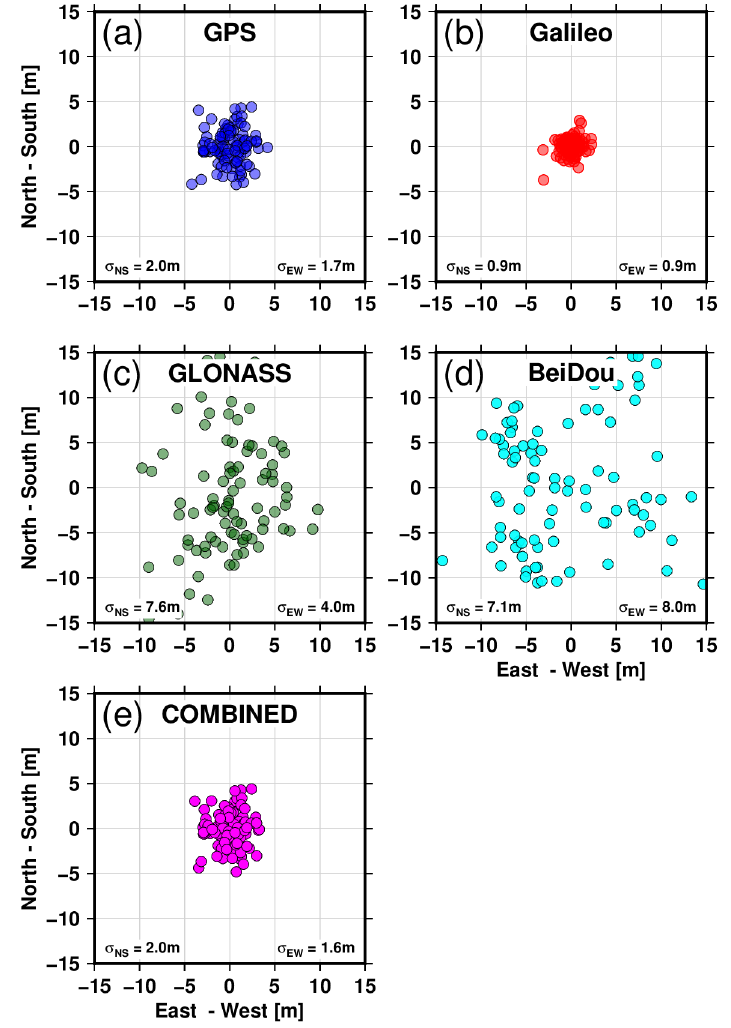
Figure 12. Single-point positioning for site KBG2, which has no Eccosorb materials mounted to its antenna again using different GNSS constellations. Results are shown in blue for GPS ( a ), in red for Galileo ( b ), in dark green for GLONASS ( c ) and cyan for BeiDou ( d ), and in the magenta for COMBINED ( e ). The positioning accuracy using GPS in the north-south direction is 2.0m and in the east-west direction, it is 1.7m; for Galileo, it is 0.9m and 0.9m respectively; for GLONASS, it